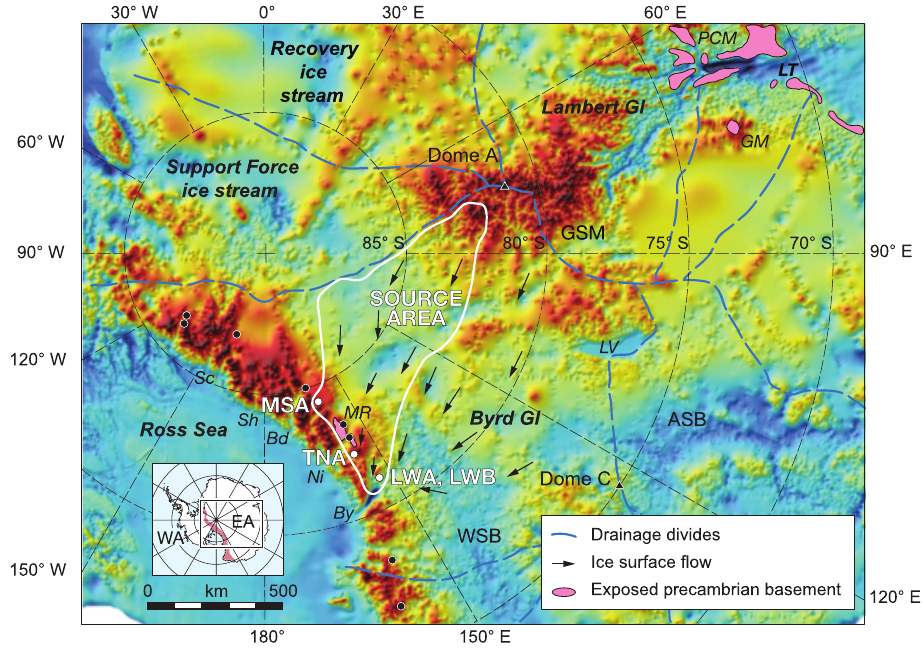
Figure 2. Map showing potential source areas for dated glacial igneous clasts, superimposed on the Bedmap2 subglacial topography of East Antarctica (Fretwell et al., 2013). Principal features are ice-sheet catchment areas (marked by thin blue drainage divides), ice flow directions in the broad Byrd Glacier drainage (arrows; Rignot et al., 2011), and areas of Precambrian basement exposure (pink). Composite source area (outlined by heavy white line) was determined from the ice flow fields that contribute ice to each of the sample sites (white circles). Other sampled sites are shown by black circles. Because transport distance is not known for any of the individual clasts, possible bedrock sources could lie anywhere between the sample sites and the top of the ice-shed overlapping the Gamburtsev Subglacial Mountains (GSM). Sample sites: LWA is Lonewolf Nunataks, MSA is Mt. Sirius, TNA is Turret Nunatak. Other abbreviations: ASB is Aurora Subglacial Basin, GM is Grove Mountains, LT is Lambert trough, LV is Lake Vostok, MR is Miller Range, PCM is Prince Charles Mountains, and WSB is Wilkes Subglacial Basin. Outlet glaciers: Bd is Beardmore, By is Byrd, Ni is Nimrod, Sc is Scott, and Sh is